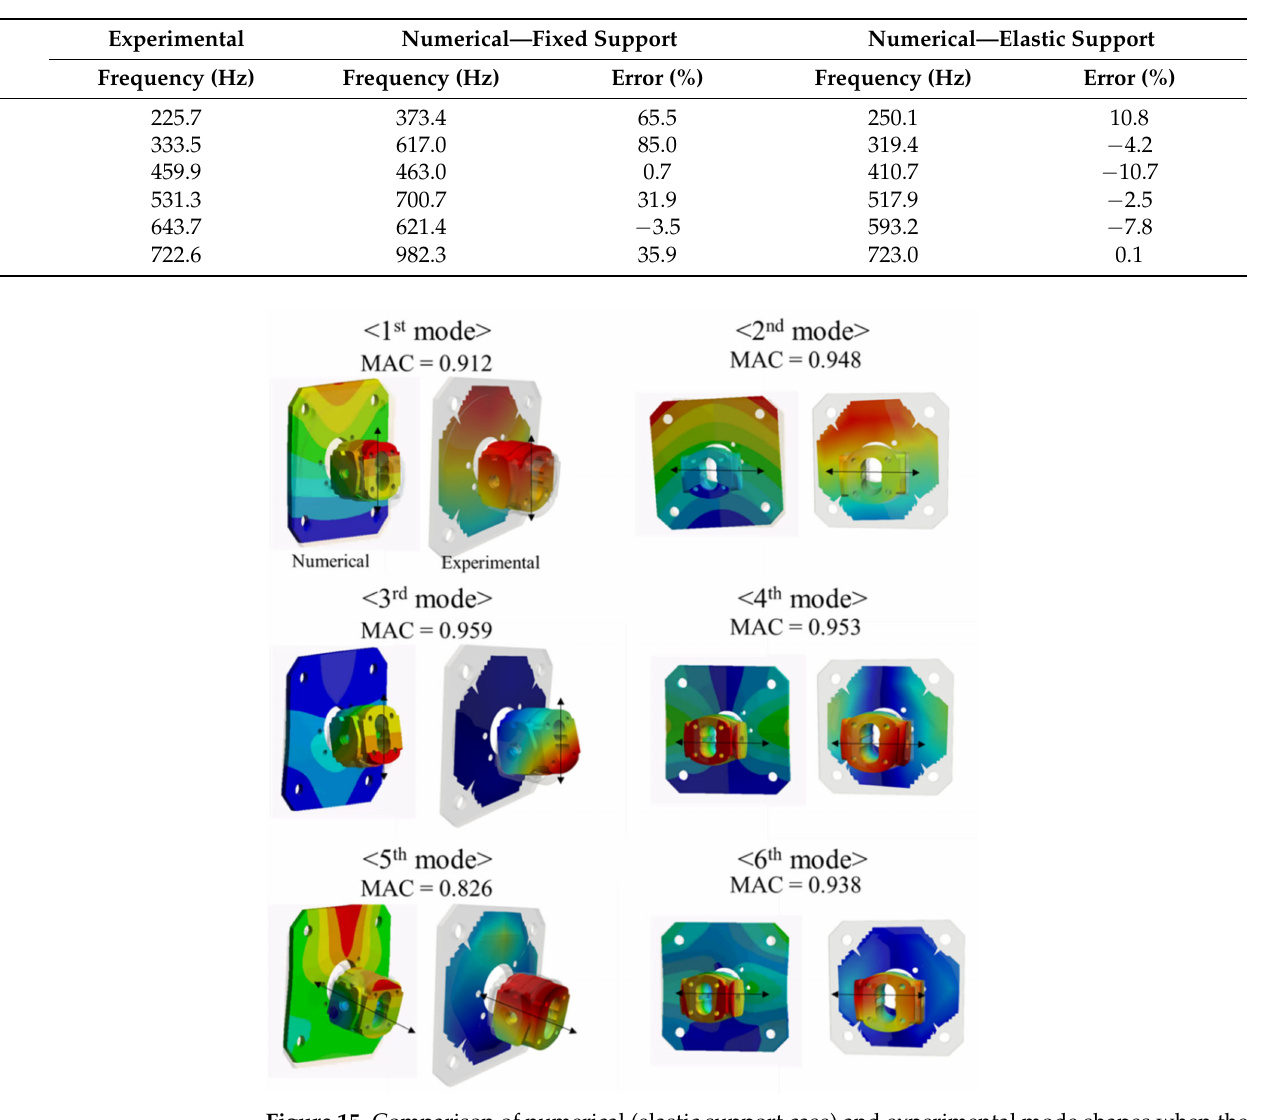
Table 5. Comparison of numerical modal frequencies with the experimental modal frequencies when the pump is mounted.